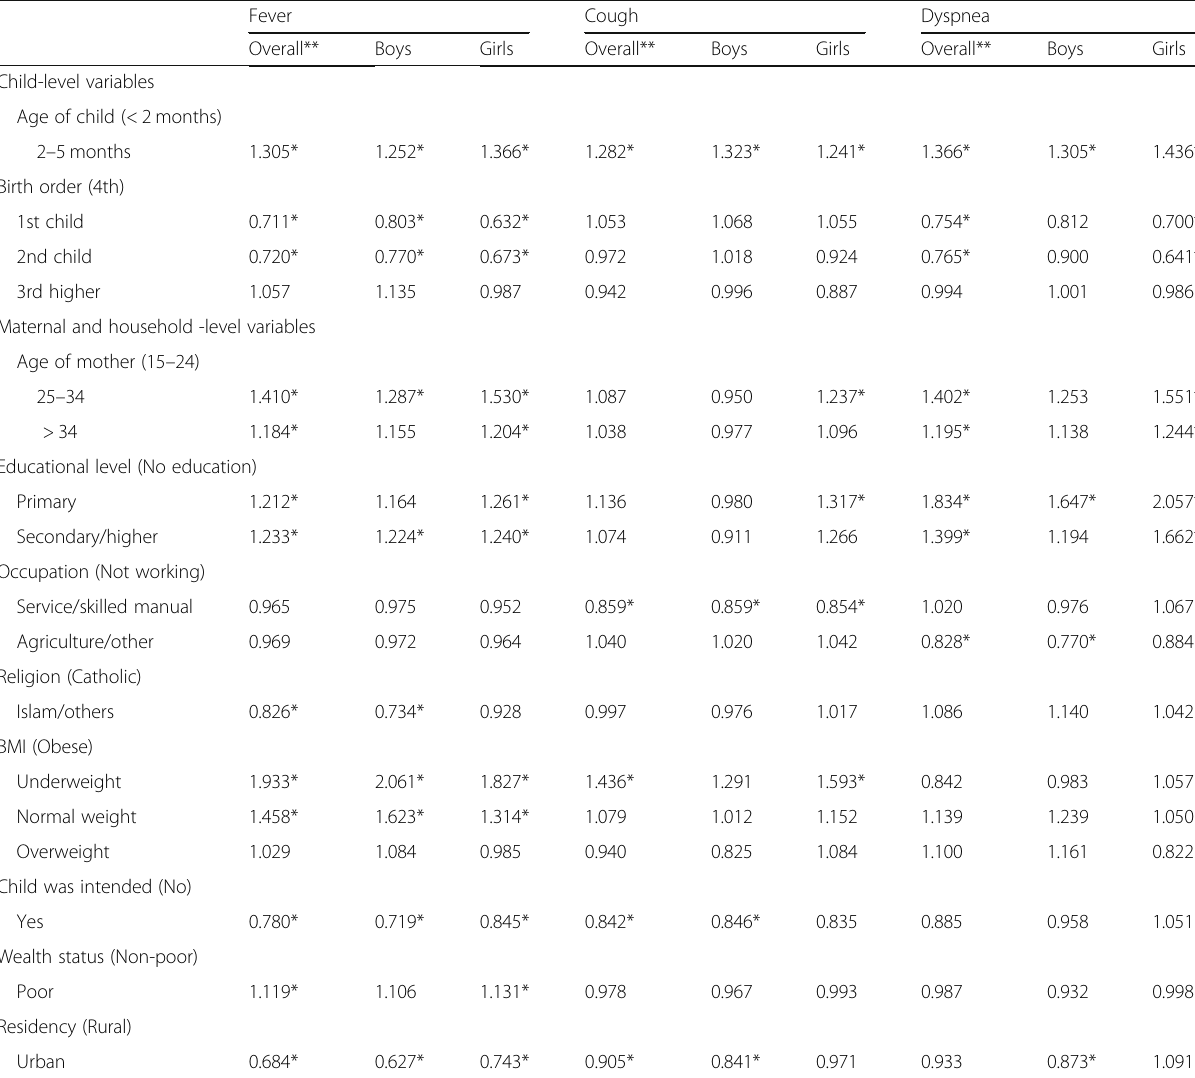
Table 3 Odds ratios of recent occurrence of fever, cough and dyspnea among Ugandan infants Fever